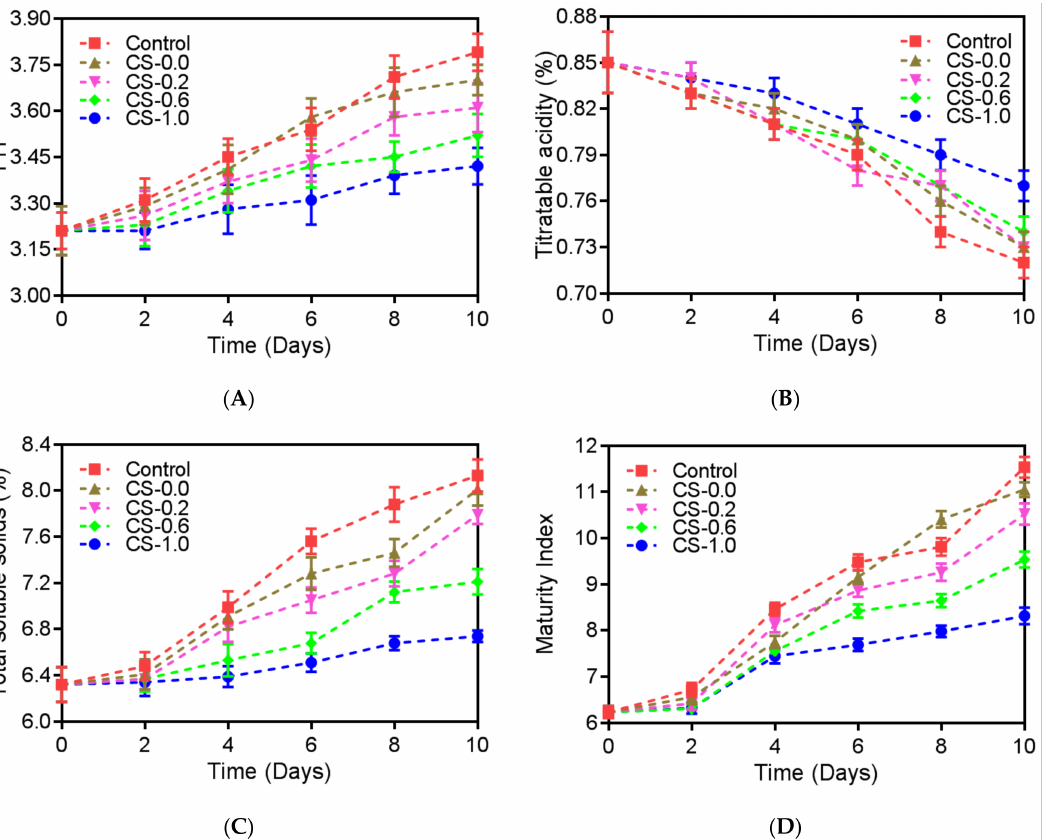
Figure 3. pH values ( A ), titrable acidity ( B ), total soluble solids ( C ), and maturity index ( D ) of strawberries during refrigeration storage (10 days). Control, strawberries packed without CS films; CS-0.0, strawberries packed with CS film CS-0.0; CS-0.2, strawberries packed with CS film CS-0.2; CS-0.6, strawberries packed with CS film CS-0.6; CS-1.0, strawberries packed with CS film